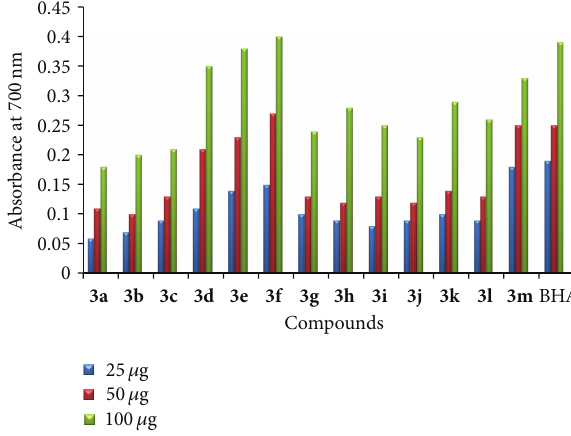
Figure 5: Ferric reducing antioxidant power activity of 3a – m .